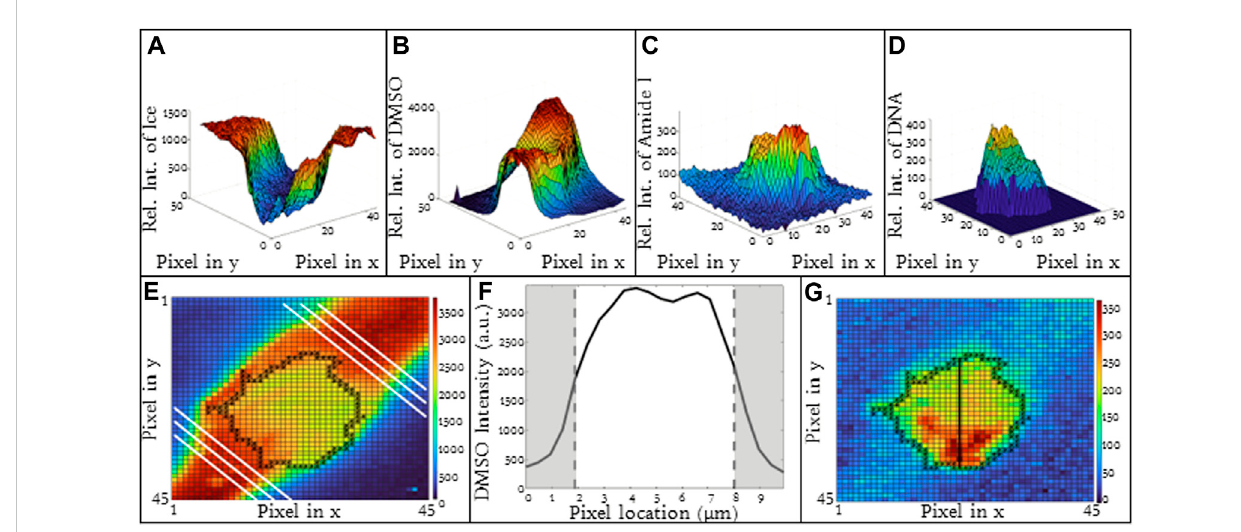
FIGURE 2 3DRamanheatmapsforaT-cellfrozenina10%DMSOsolutionusingacoolingrateof − 1 ° C/minandimagingat − 50 ° C.Heatmapsshowintensityof (A) ice, (B) DMSO, (C) cell (amide I), (D) DNA. (E) Heat map of DMSO distribution in the extracellular space (F) average DMSO concentration in the extracelluarspacebetween icecrystalsindicatedbythewhitelinesas notedin2E. (G) Ramanheat mapofDNAdistributioninaJurkat cell.Regions inred indicate high concentrations of DNA. Pixels in (A) , (B) , (C) , and (G) have a height and width of 333 nm. (F) Regions of gray indicate ice regions and white is extracellular